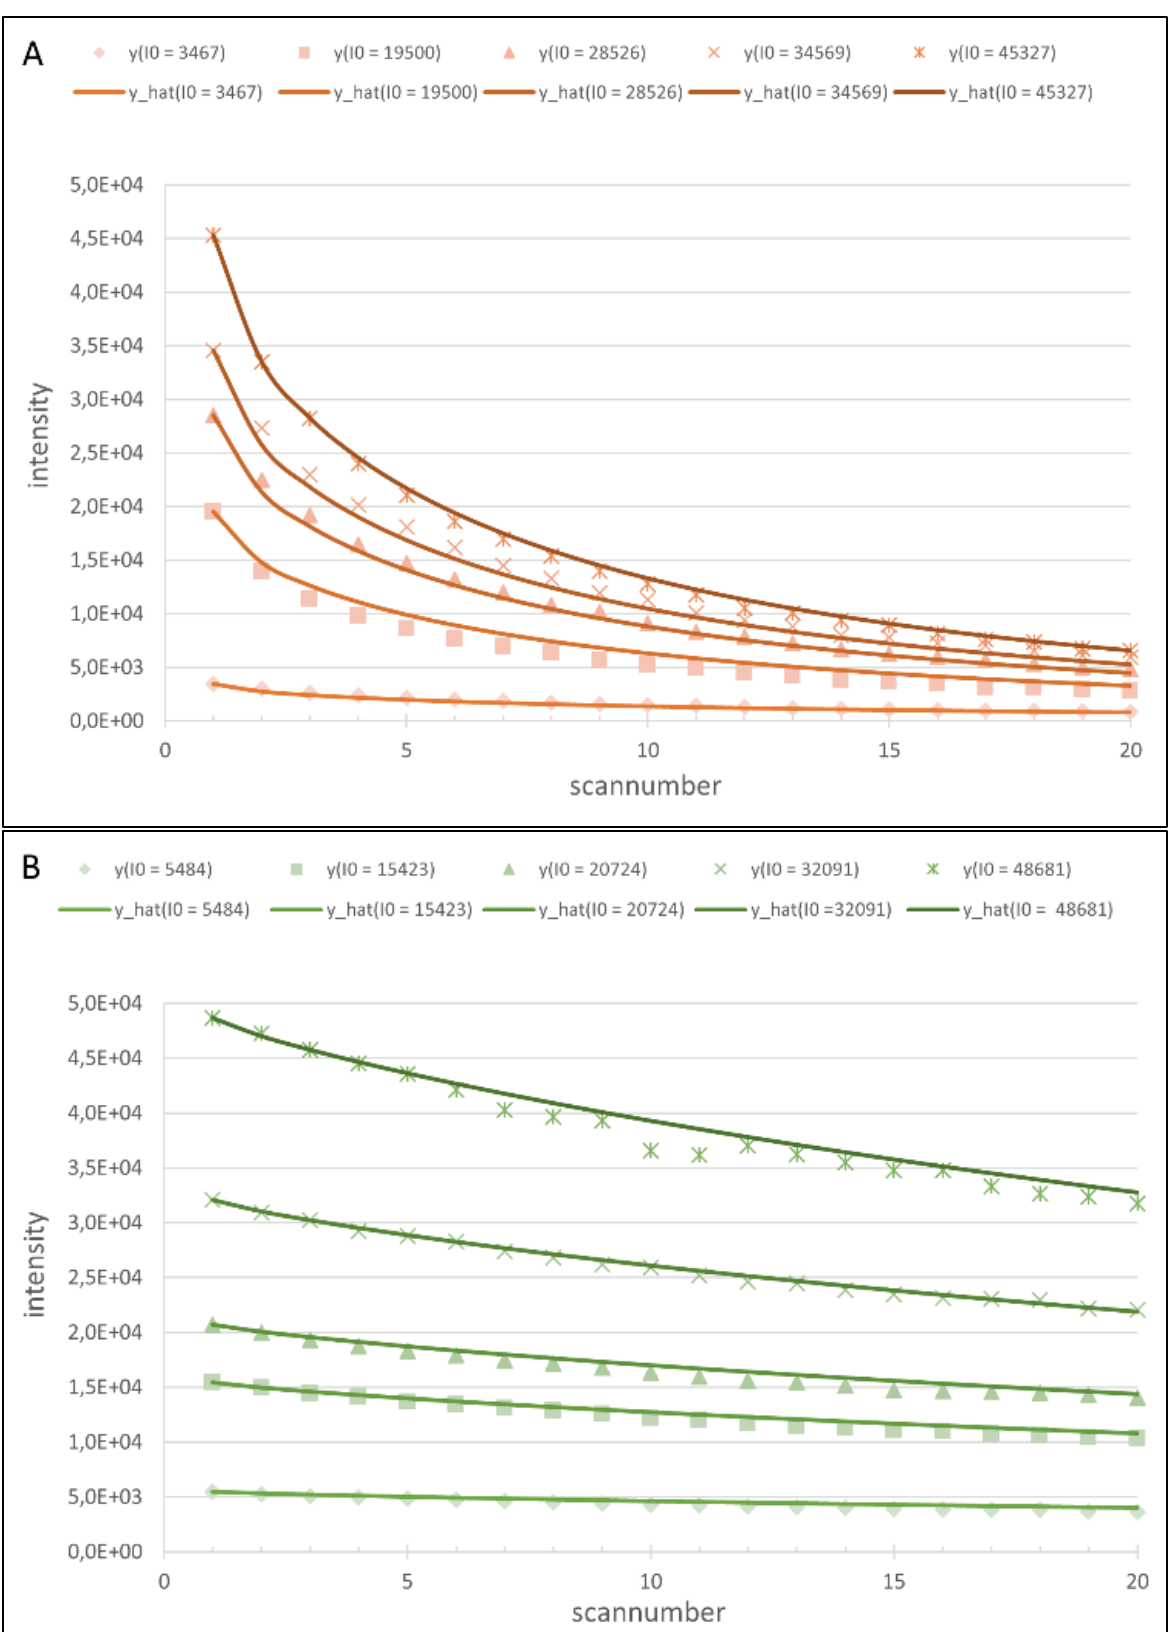
Figure 4. ( A ) Cy5-data sets ( y(I0) ) with model-data ( y_hat(I0) ) at V PMT = 750. R 2 : 0.994, 0.995, 0.998, 0.998, 0.999 (from lowest I0 to highest); and ( B ) Cy5-data sets ( y(I0) ) with fits ( y_hat(I0) ) at V PMT = 500. R 2 : 0.994, 0.997, 0.991, 0.995, 0.984 (from lowest I0 to